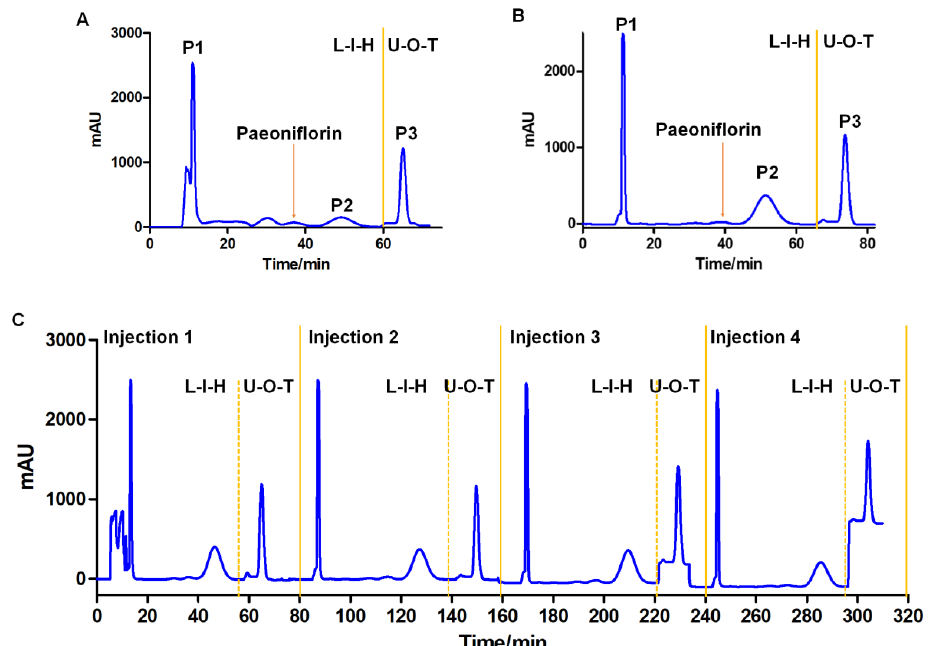
Figure 7. HPCCC separation of the paeoniflorin conversion products from analytical ( A ) to semi-preparative ( B ) to continuous injection in semi-preparative ( C ). ( A ) Analytical scale: sample, 30 mg/0.5 mL; column, Spectrum HPCCC-22.5 mL; flow rate, 1.0 mL/min; rotational speed, 250 g; retention of the stationary phase, 58.4%; ( B ) Semi-preparative scale: sample, 97 mg/2 mL; Spectrum HPCCC-133.5 mL; flow rate, 4.0 mL/min; rotational speed, 250 g; retention of the stationary phase, 56.7%; ( C ) Continuous injection in semi-preparative; other conditions are the same for ( A – C ), elution time: 60 min for L-I-H mode (reversed phase elution) and 20 min for U-O-T mode (normal phase elution); detection wavelength, 230 nm.